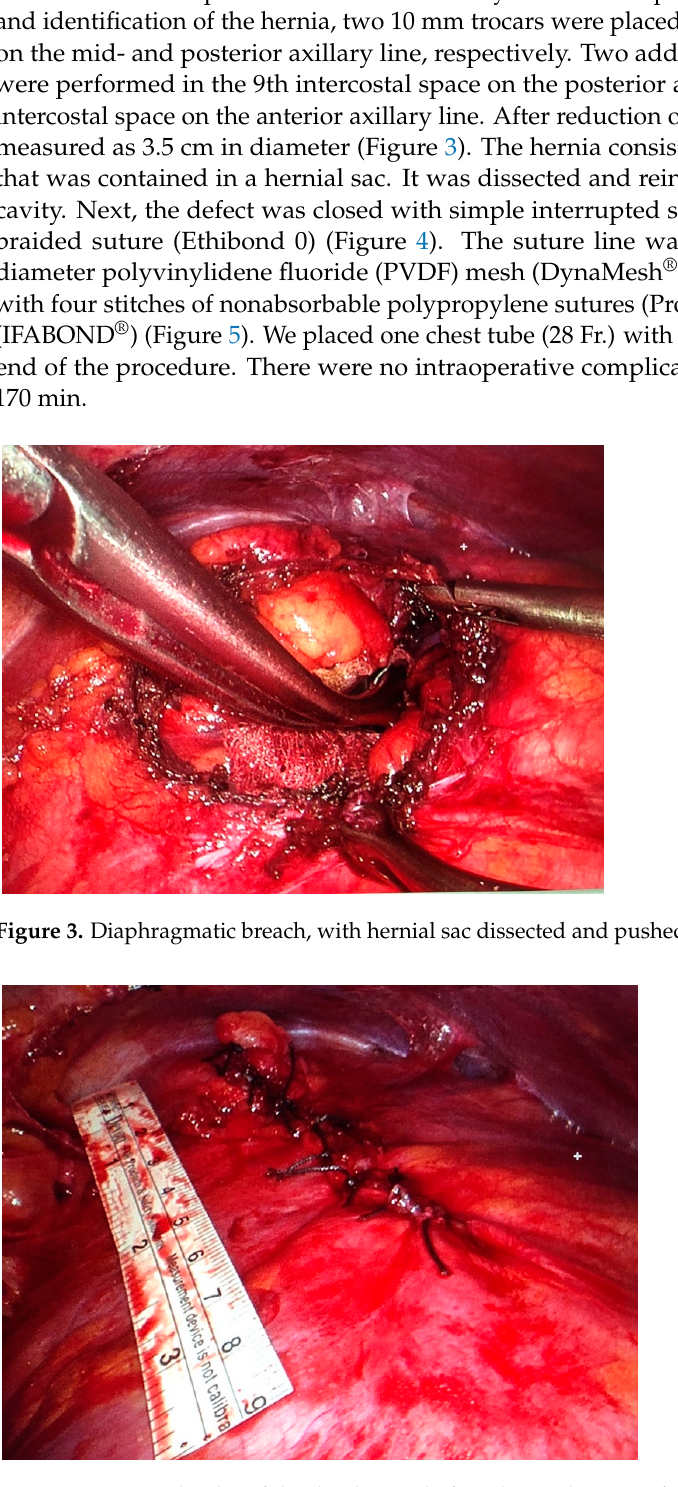
Figure 5. Application of the polyvinylidene fluoride (PVDF) mesh (DynaMesh ® -IPOM) anchored with four Prolene 2-0 stitches and surgical glue (IFABOND ® ).